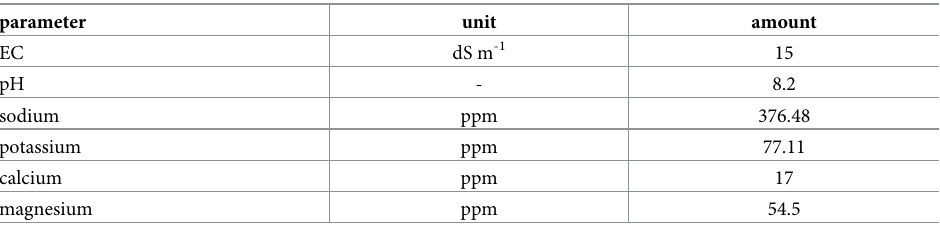
Table 1. Chemical analysis of Caspian Sea water